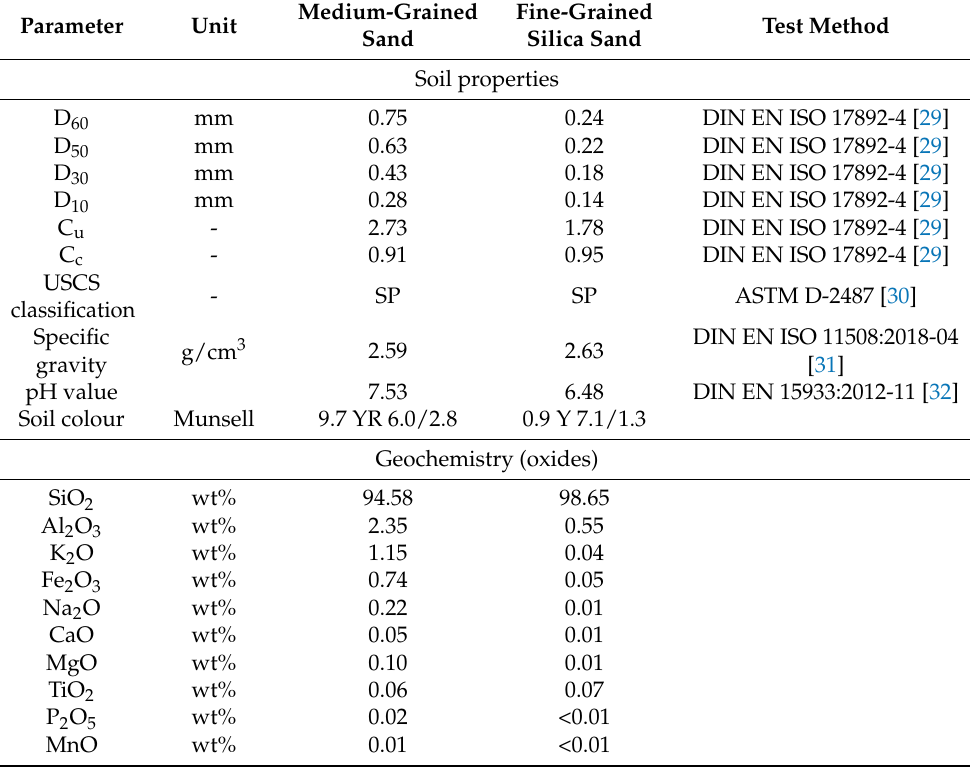
Table 1. Physical and chemical properties of mine soils used by this study. Parameter Unit